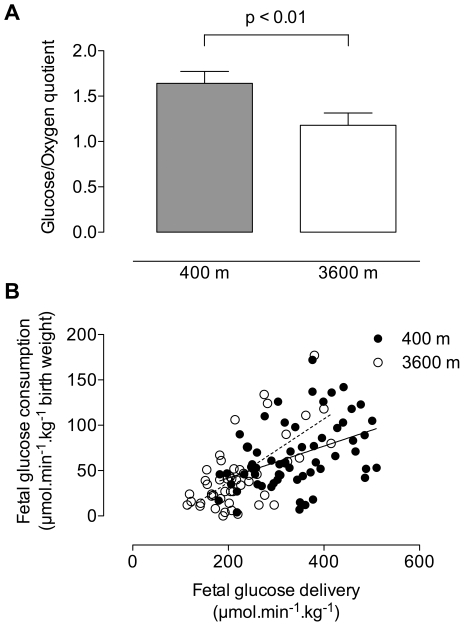
Indicators of fetal glucose metabolism.(A) The fetal glucose/oxygen quotient (6 x fetal glucose consumption/fetal oxygen consumption) was greater at 400 m (1.64±0.13) than at 3600 m (1.18±0.13 p<0.01). (B) Fetal glucose delivery and fetal glucose consumption were positively correlated both altitudes (y = 0.08+0.176x, r2 = 0.18, p<0.001 at 400 m; y = 0.23+0.35x, r2 = 0.43, p<0.0001 at 3600 m).